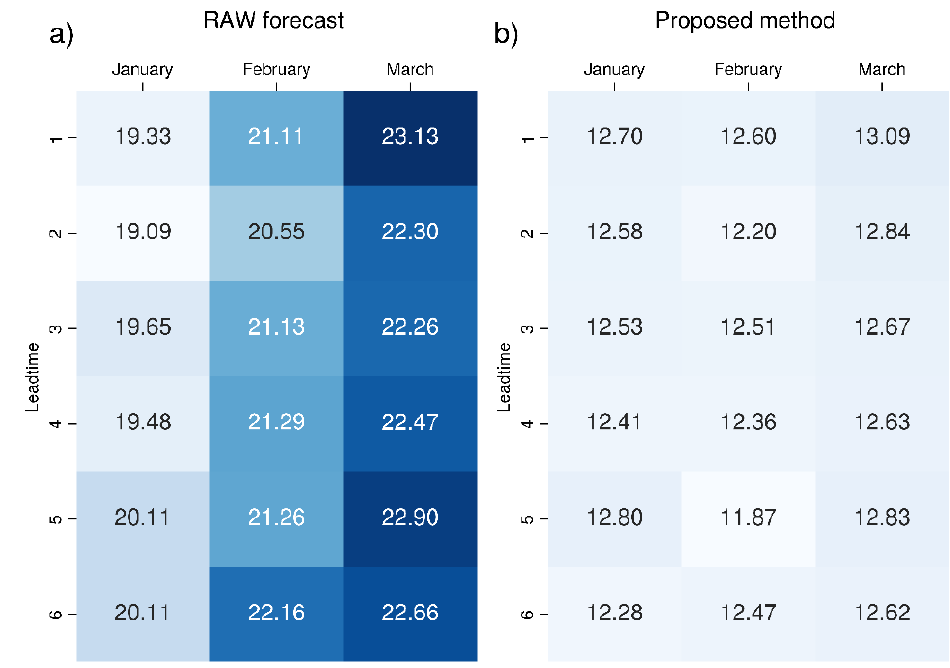
Figure 14. Mean percentage of ensemble members correctly predicting total precipitation over the 99th percentile value for seasonal forecast SEAS5 (ECMWF): ( a ) raw data and ( b ) data corrected with the proposed bias correction method. The colour scale ranges from white (0%) to dark blue, increasing in intensity as the percentage increases. The most intense colour corresponds to the maximum